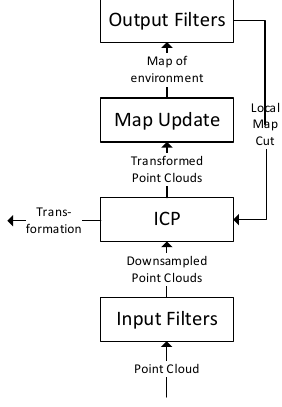
Figure 4. Processing pipeline of the